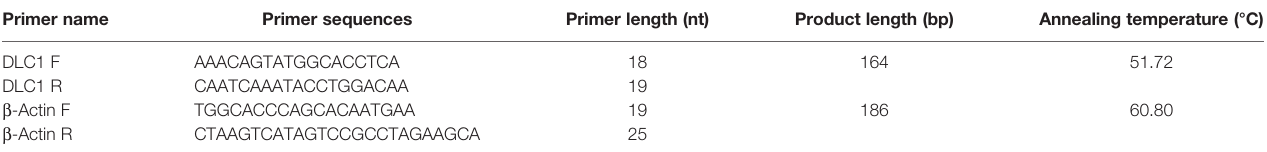
TABLE 2 | The primer sequences used for ampli fi